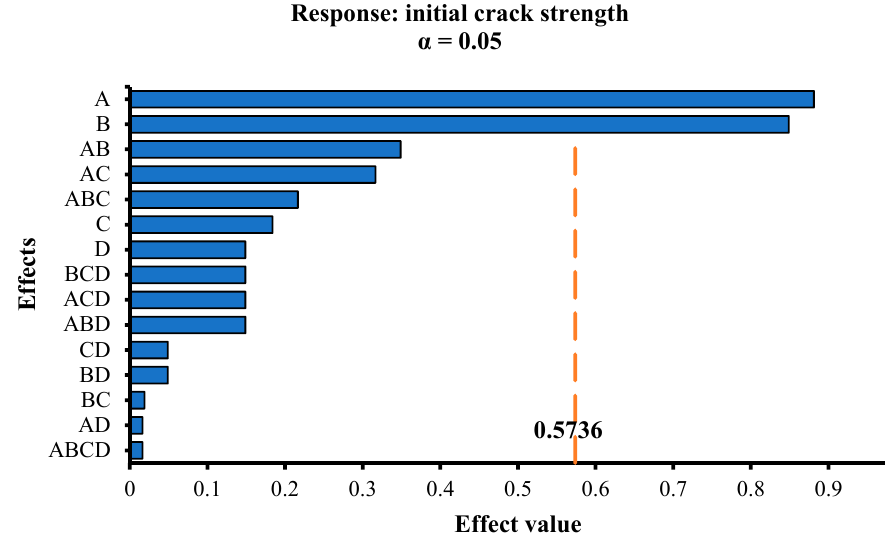
Figure 9. Pareto chart of the initial crack strength.